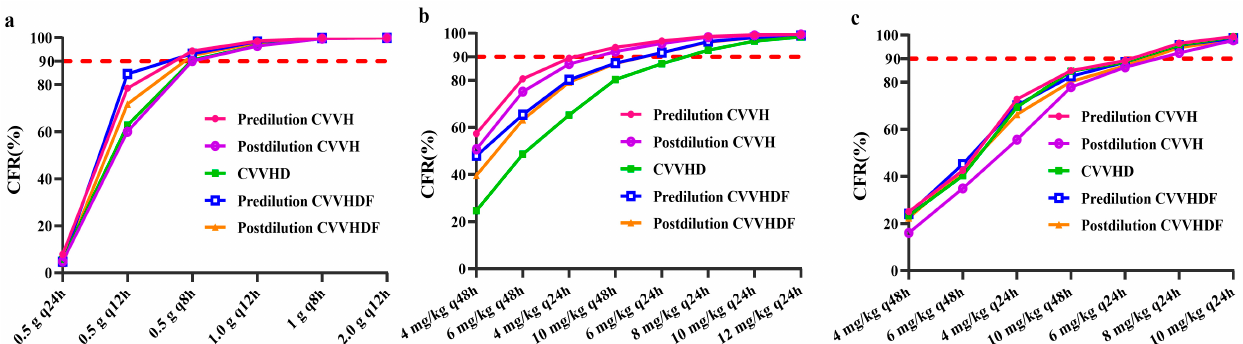
Figure 3. The cumulative fraction of response (CFR) values of three antimicrobial agents in different maintenance doses for patients undergoing continuous renal replacement therapy. The red dashed horizontal line indicates 90% PTA. ( a )—Vancomycin; ( b )—Teicoplanin; ( c )—Daptomycin.